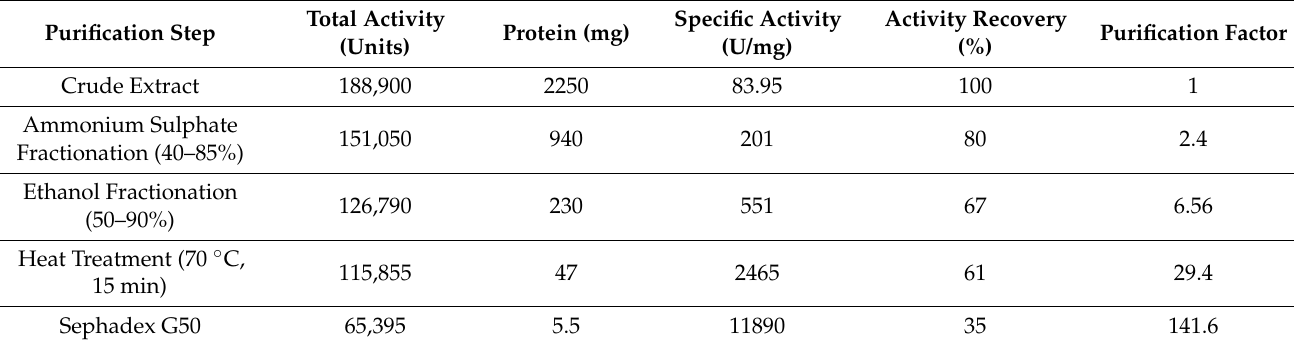
Figure 2A represents the elution profile of gel filtration through a Sephadex